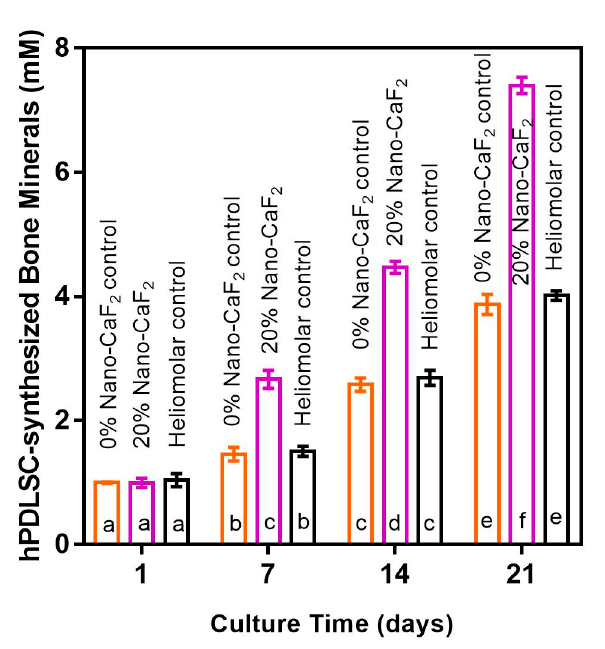
Figure 9. Quantitative bone mineral synthesis amounts by hPDLSCs on 20% Nano-CaF 2 composite. The hPDLSC-synthesized bone minerals on 20% Nano-CaF 2 composite at 14 and 21 days was nearly 2-fold those of the other groups ( p < 0.05). Values with dissimilar letters are significantly di ff erent from each other. Values with dissimilar letters such as a and b are significantly di ff erent ( p < 0.05, mean ± SD; n = 6).